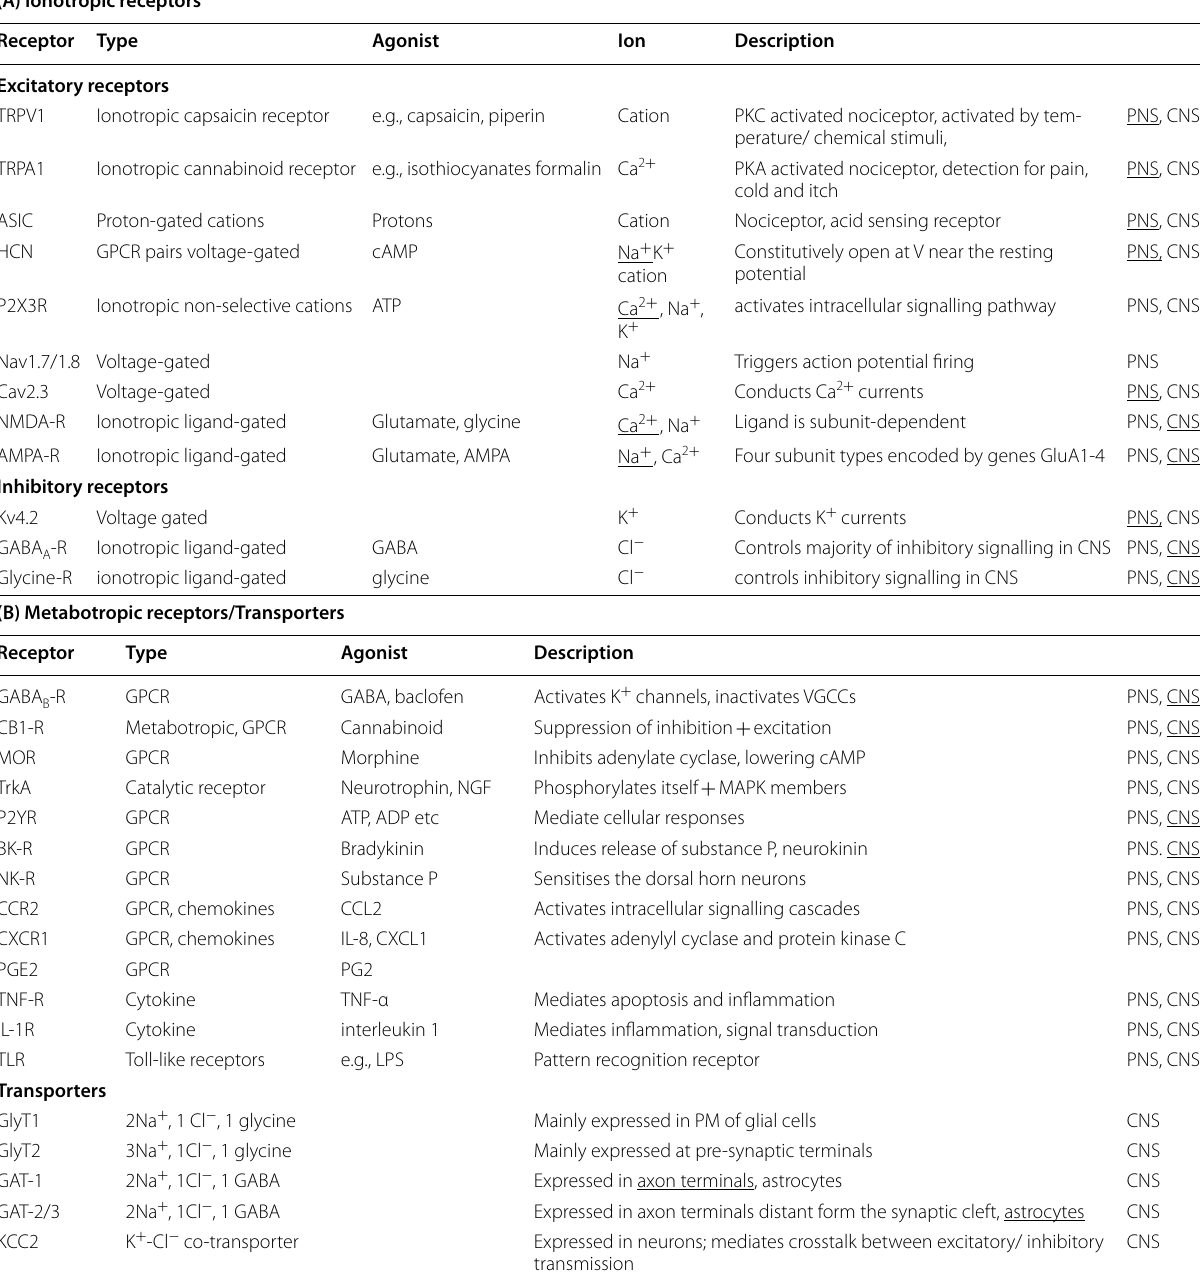
Table 1 Membrane receptors in pain